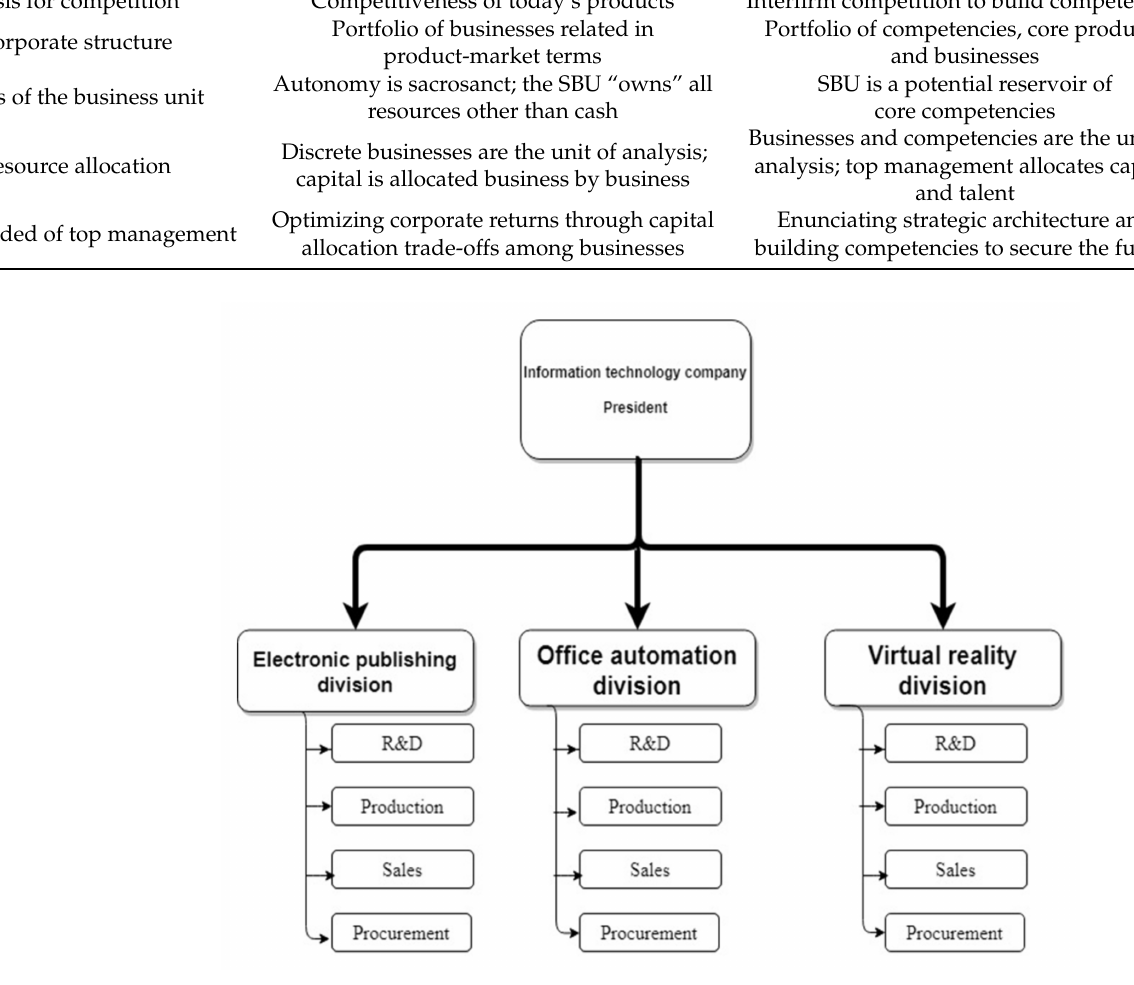
Figure 1. Chart of divisional